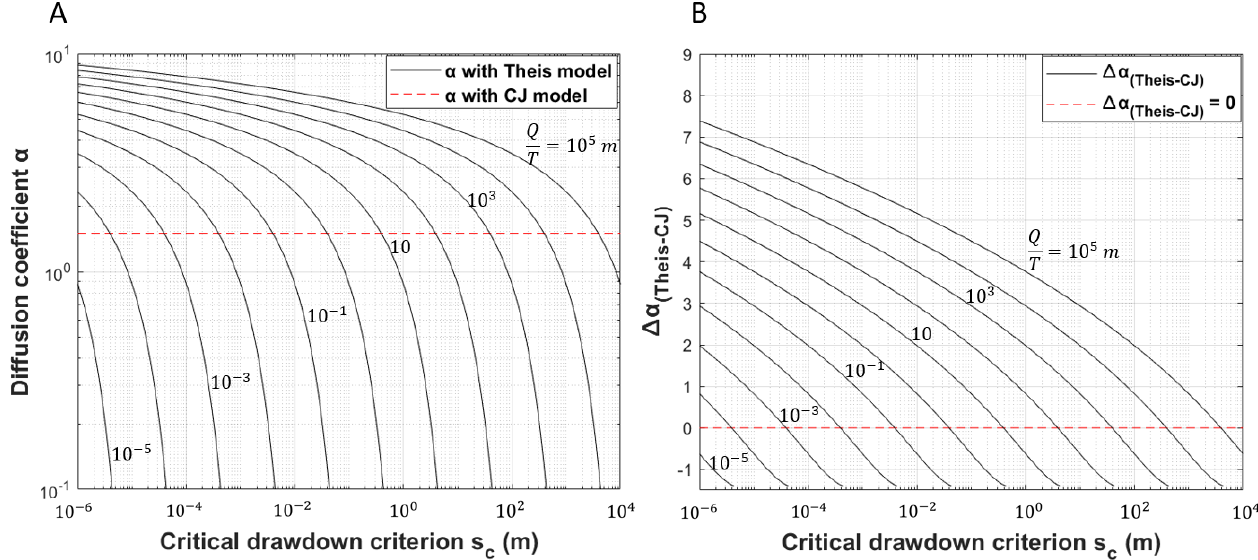
Figure 3. Illustration of simulated drawdown curves predicted by Theis and CJ models at 𝑟 = 6 m for a pumping test with 𝑄 = 0.2 m (cid:2871) /s , 𝑇 = 0.01 m (cid:2870) /s and 𝑆 = 0.001 .